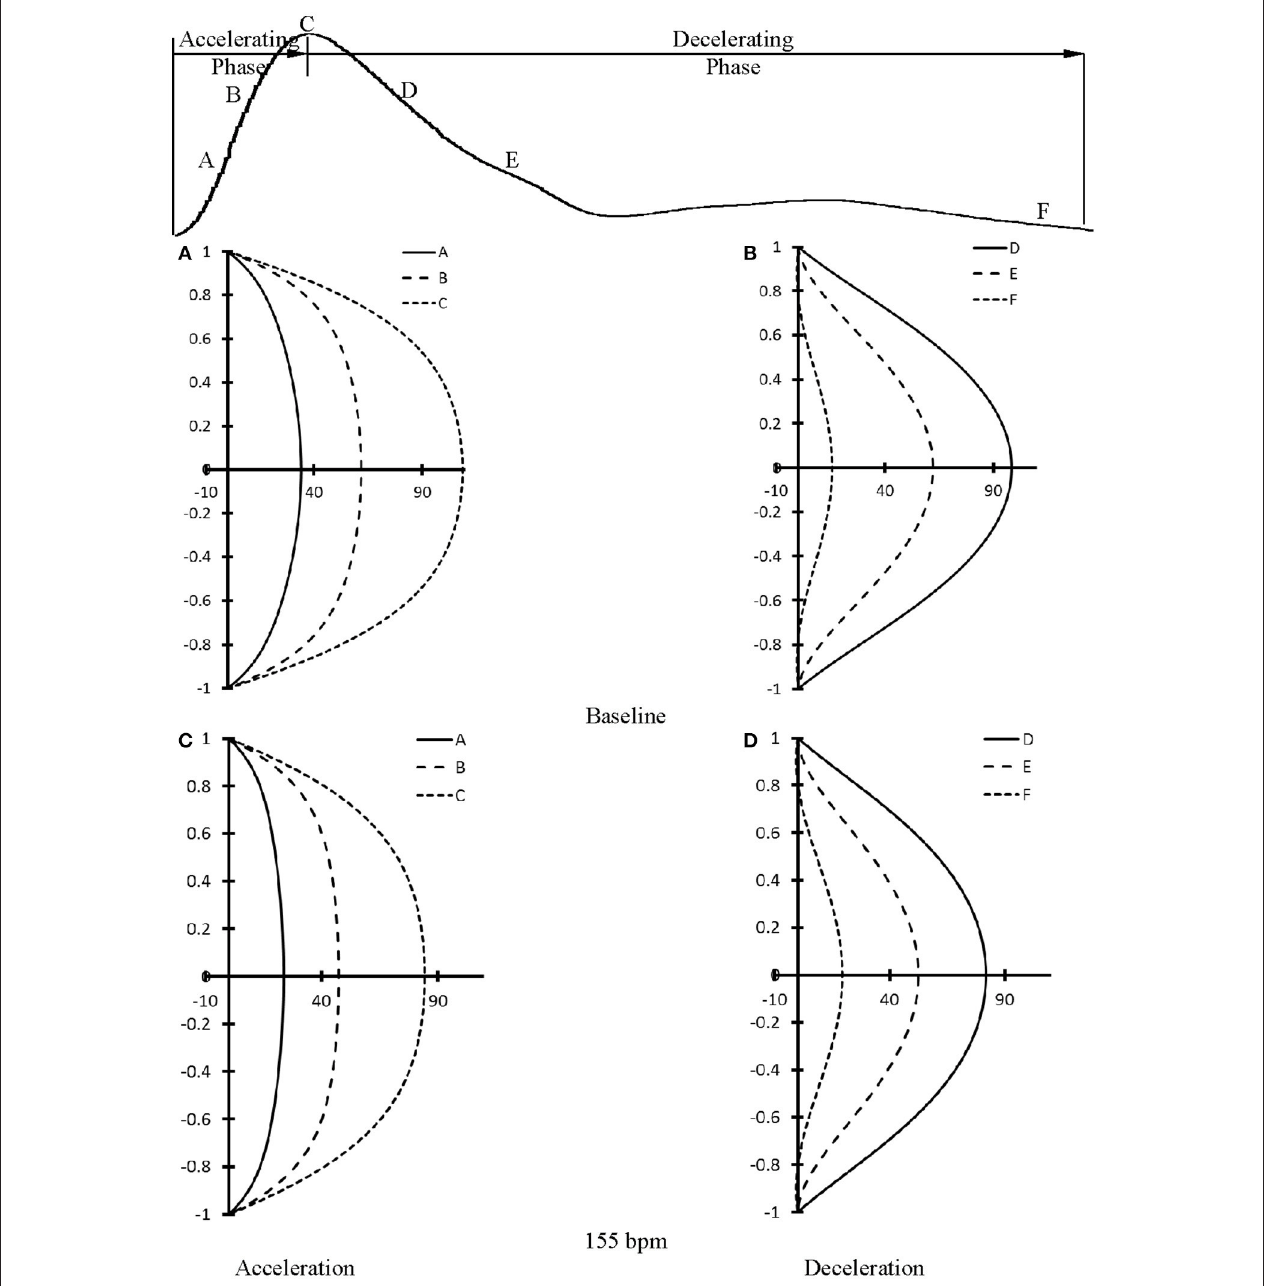
FIGURE 6 | Flow velocity profiles in femoral artery at various time instances during (A) accelerating and (B) decelerating periods at baseline. (C,D) refer to flow velocity profiles in femoral artery after the heart rate was paced to 155 bpm in correspondence with (A,B) . (A–F) in (A–D) refer to time instances A–F as shown in the top curve.